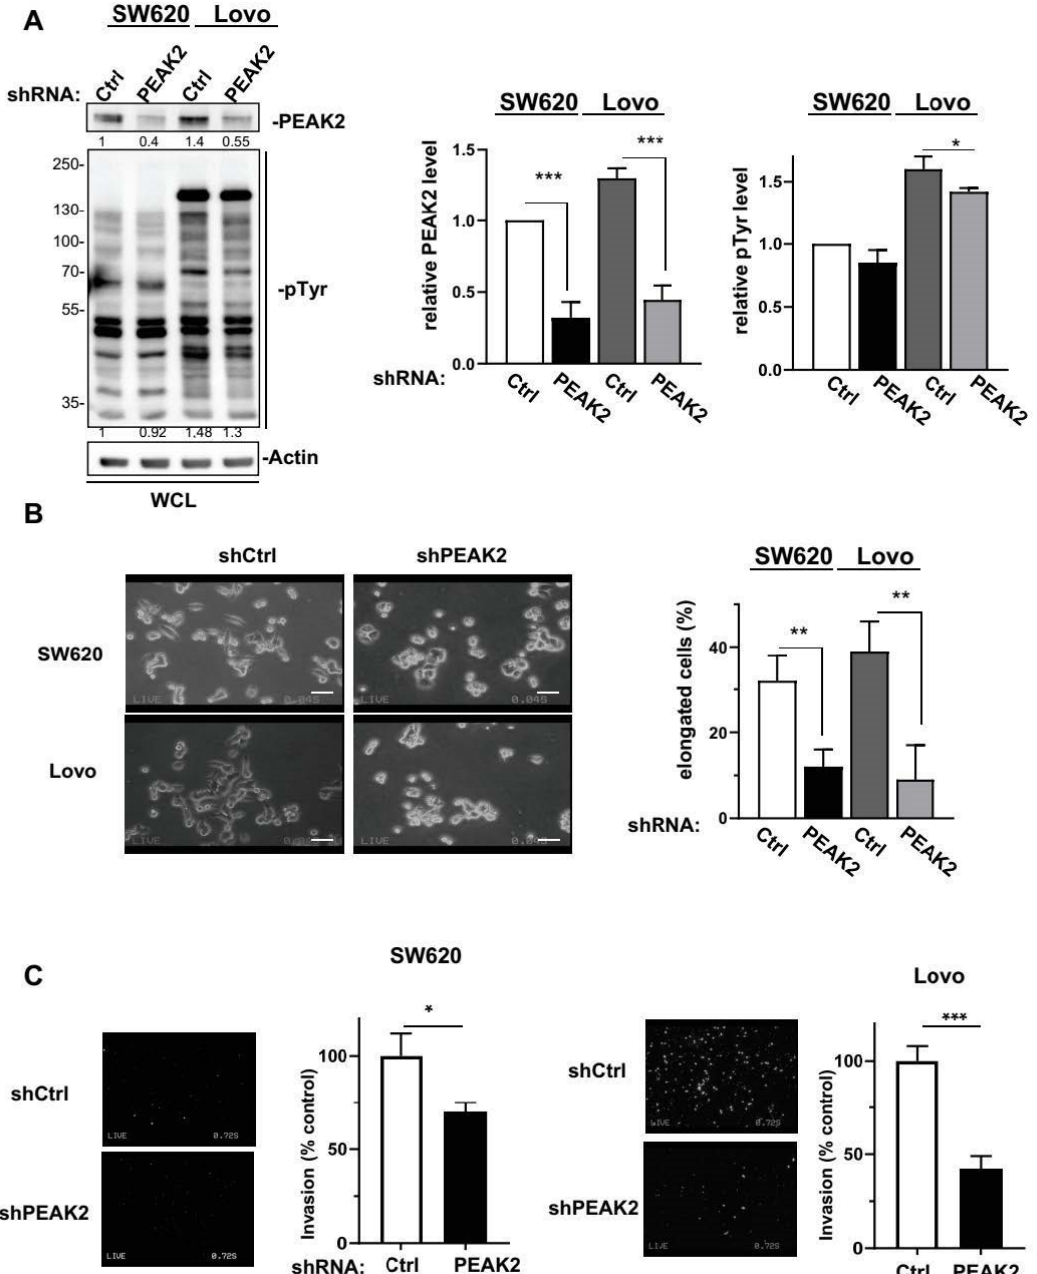
Figure 2. PEAK2 regulates CRC cell morphology and invasion. PEAK2 depletion by shRNA inhibits CRC cell growth and invasion. ( A ) Cellular protein tyrosine phosphorylation and PEAK2 level in CRC cells transduced with indicated shRNA (left: a representative example, right: quantification). ( B ) Morphology of CRC cells transduced with indicated shRNA (left: a representative example, right: quantification of the % of elongated cells). ( C ) Invasion of CRC cells transduced with indicated shRNA in Boyden chambers coated with matrigel (left: presentative image, right: quantification of number of invaded cells). Mean ± SEM; n = 3; * p < 0.05; ** p < 0.01; *** p < 0.001 (Student’s t